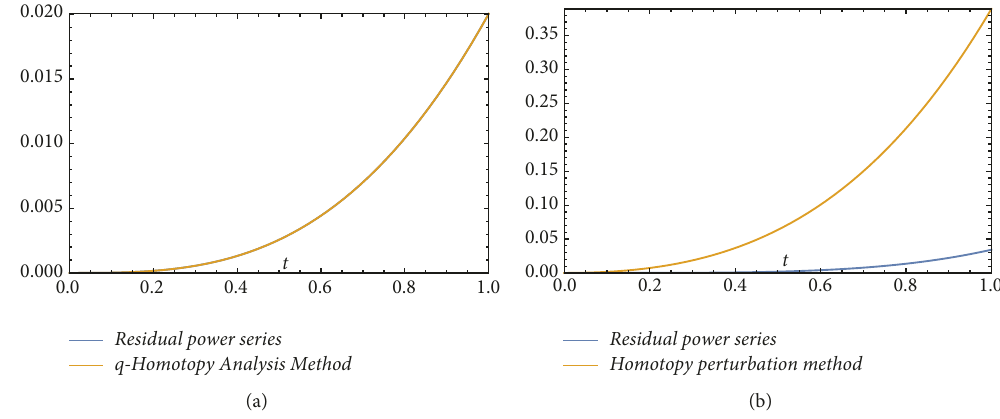
Figure 1: (a) Absolute errors of fractional Gardner equation, at 𝑥 = 2, 𝜀 = 1 . (b) Absolute errors of fractional Chan-Hilliard equation at 𝑥 = 2 .